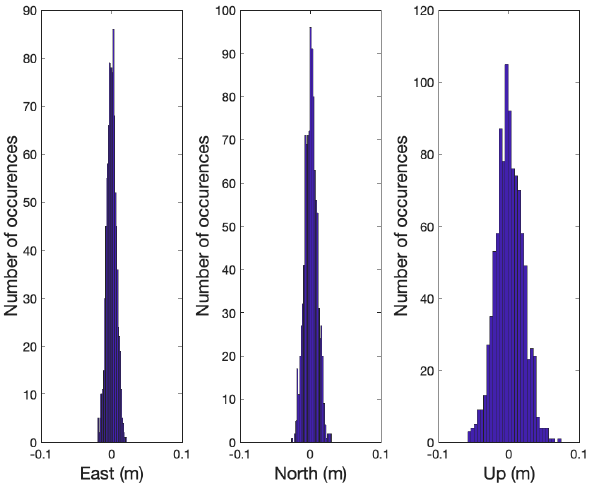
Figure 9. The figure shows the error distribution of the follower relative position in ENU coordinates after resolving the integer ambiguities of all satellites in 1000 simulation cases. All of the integer ambiguities were resolved at 16th epoch, and the position errors in the distribution were computed at the same epoch.